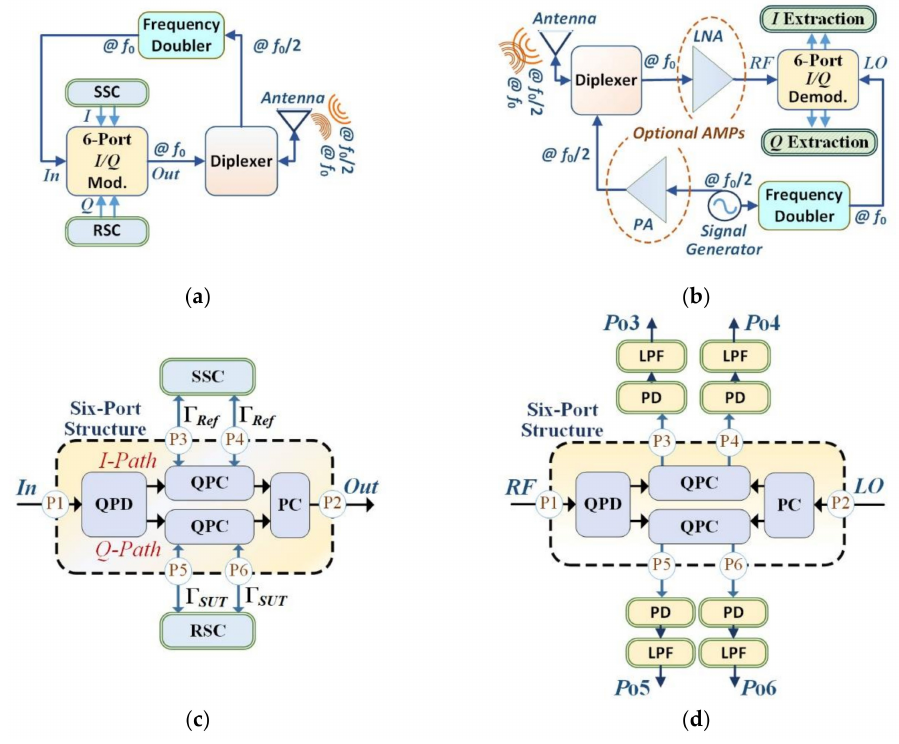
Figure 2. Functional block diagrams of system’s sub-circuits: ( a ) The sensor node; ( b ) The base station; ( c ) The six-port sensor; ( d ) The six-port